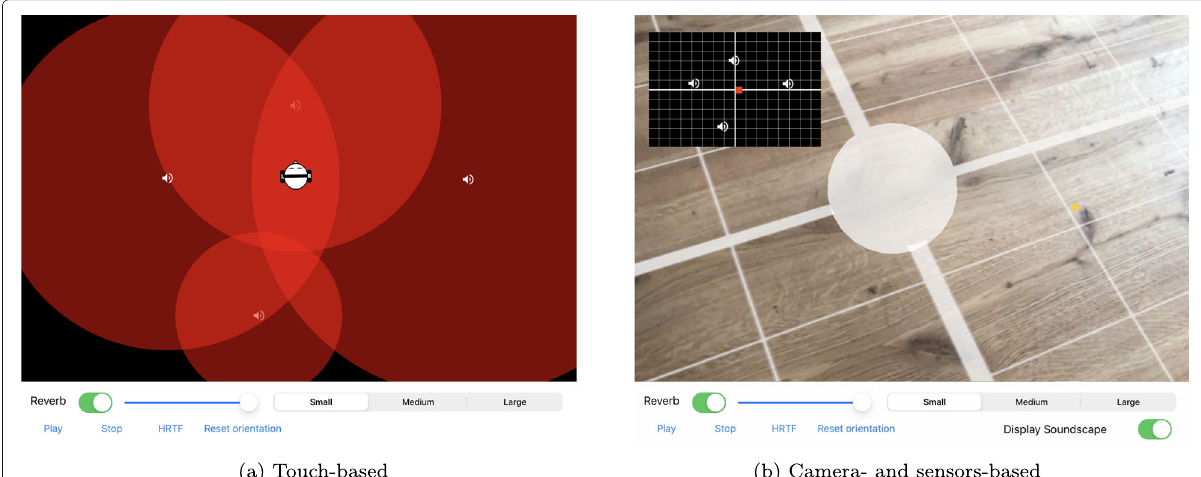
Fig. 5 PlugSonic Soundscape Experience Mobile